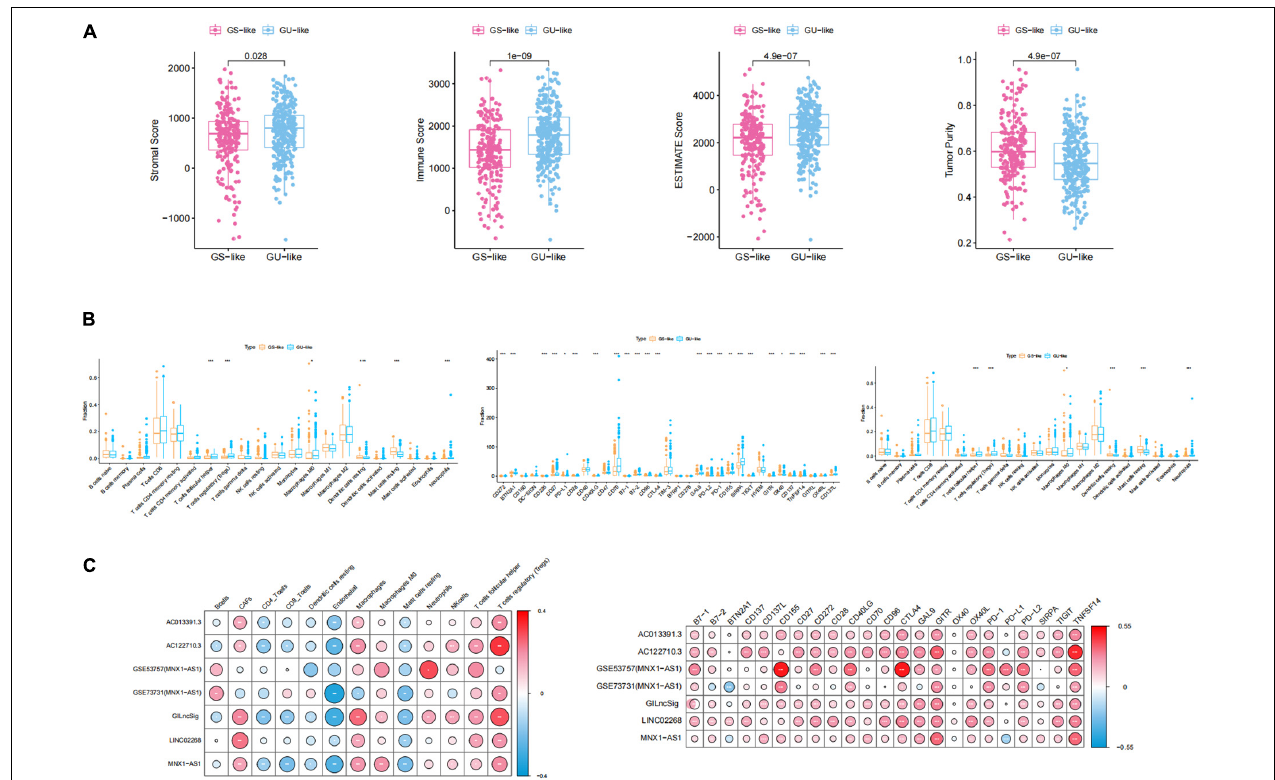
FIGURE 8 | Identification of the characteristics of immune microenvironment and genomic instability and description of the immune atlas of genomic instability. (A) Boxplot of the expression level of ImmuneScore, ESTIMATE, StromalScore, and TumorPurity in the GU-like group and GS-like group. The expression level of ImmuneScore, ESTIMATE, and StromalScore in the GU-like group was significantly higher than that in the GS-like group. However, the expression level of TumorPurity in the GU-like group was significantly lower than that in the GS-like group. (B) Boxplot of the expression level of immune-associated cells and immune checkpoints in the GU-like group and GS-like group. (C) Correlation of immune cells and immune checkpoints with lncRNAs in TCGA samples and GEO samples. Regulatory T cells (Tregs), CTLA4, GITR, and TNFSF14 had a significant positive correlation with genomic instability characteristics and endothelial cells had a significant negative correlation with genomic instability